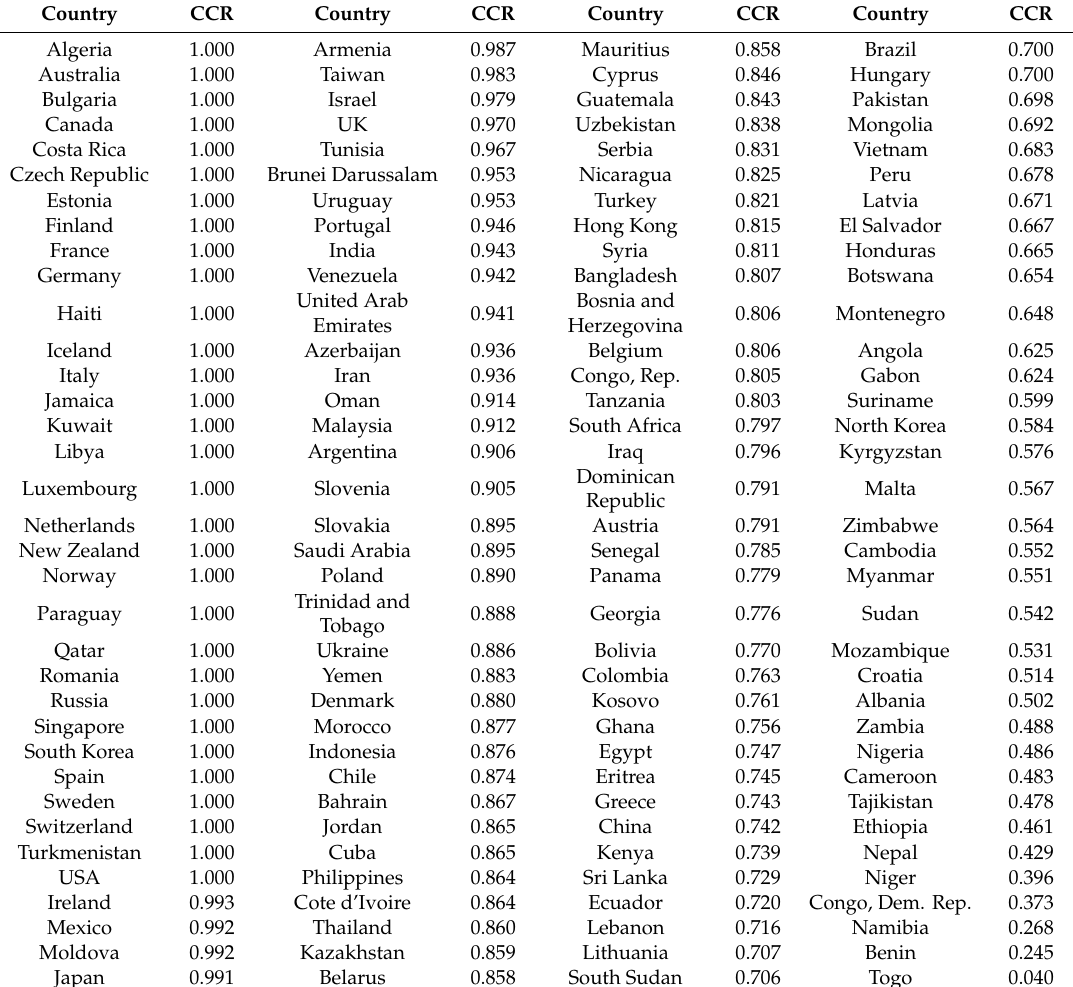
Table 3. Charnes, Cooper, and Rhodes (CCR) maximum e ffi ciencies of the 140 countries.